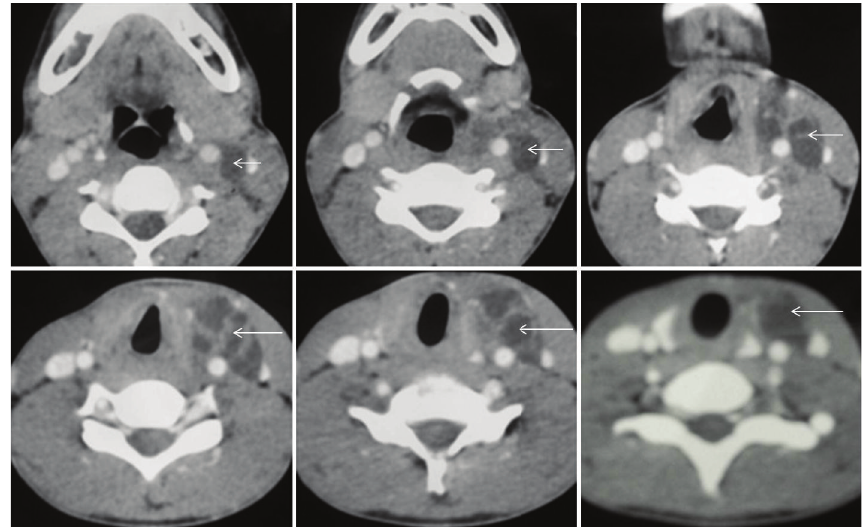
Figure 1: CT scan of the neck showed a multiloculated fluid density lesion with enhancing septae in the left parapharyngeal space, extending from the level of mandible up to C7 vertebral level.